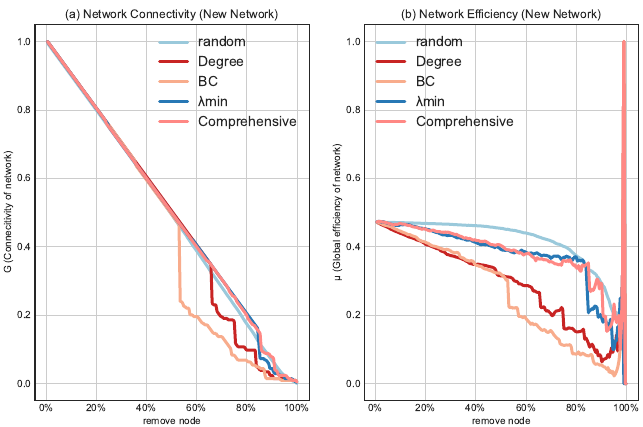
Figure 7. Virtual network random attack and malicious attack effect. ( a ) The change in virtual network connectivity after deleting nodes in sequence according to the 5 methods. ( b ) The change in virtual network efficiency after deleting nodes in sequence according to the 5